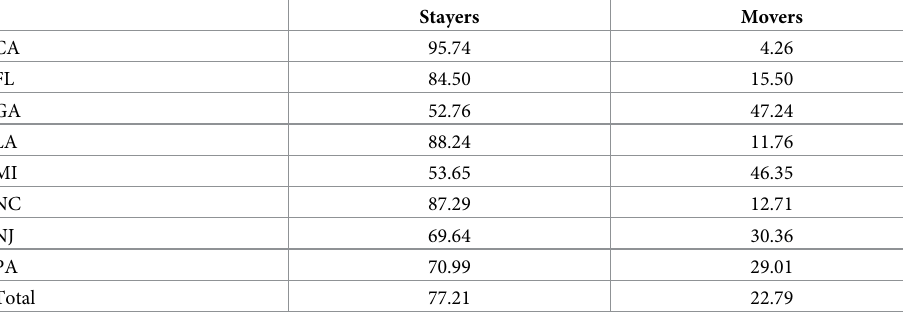
Table 2. Distribution of stayers and movers, by state of residence.